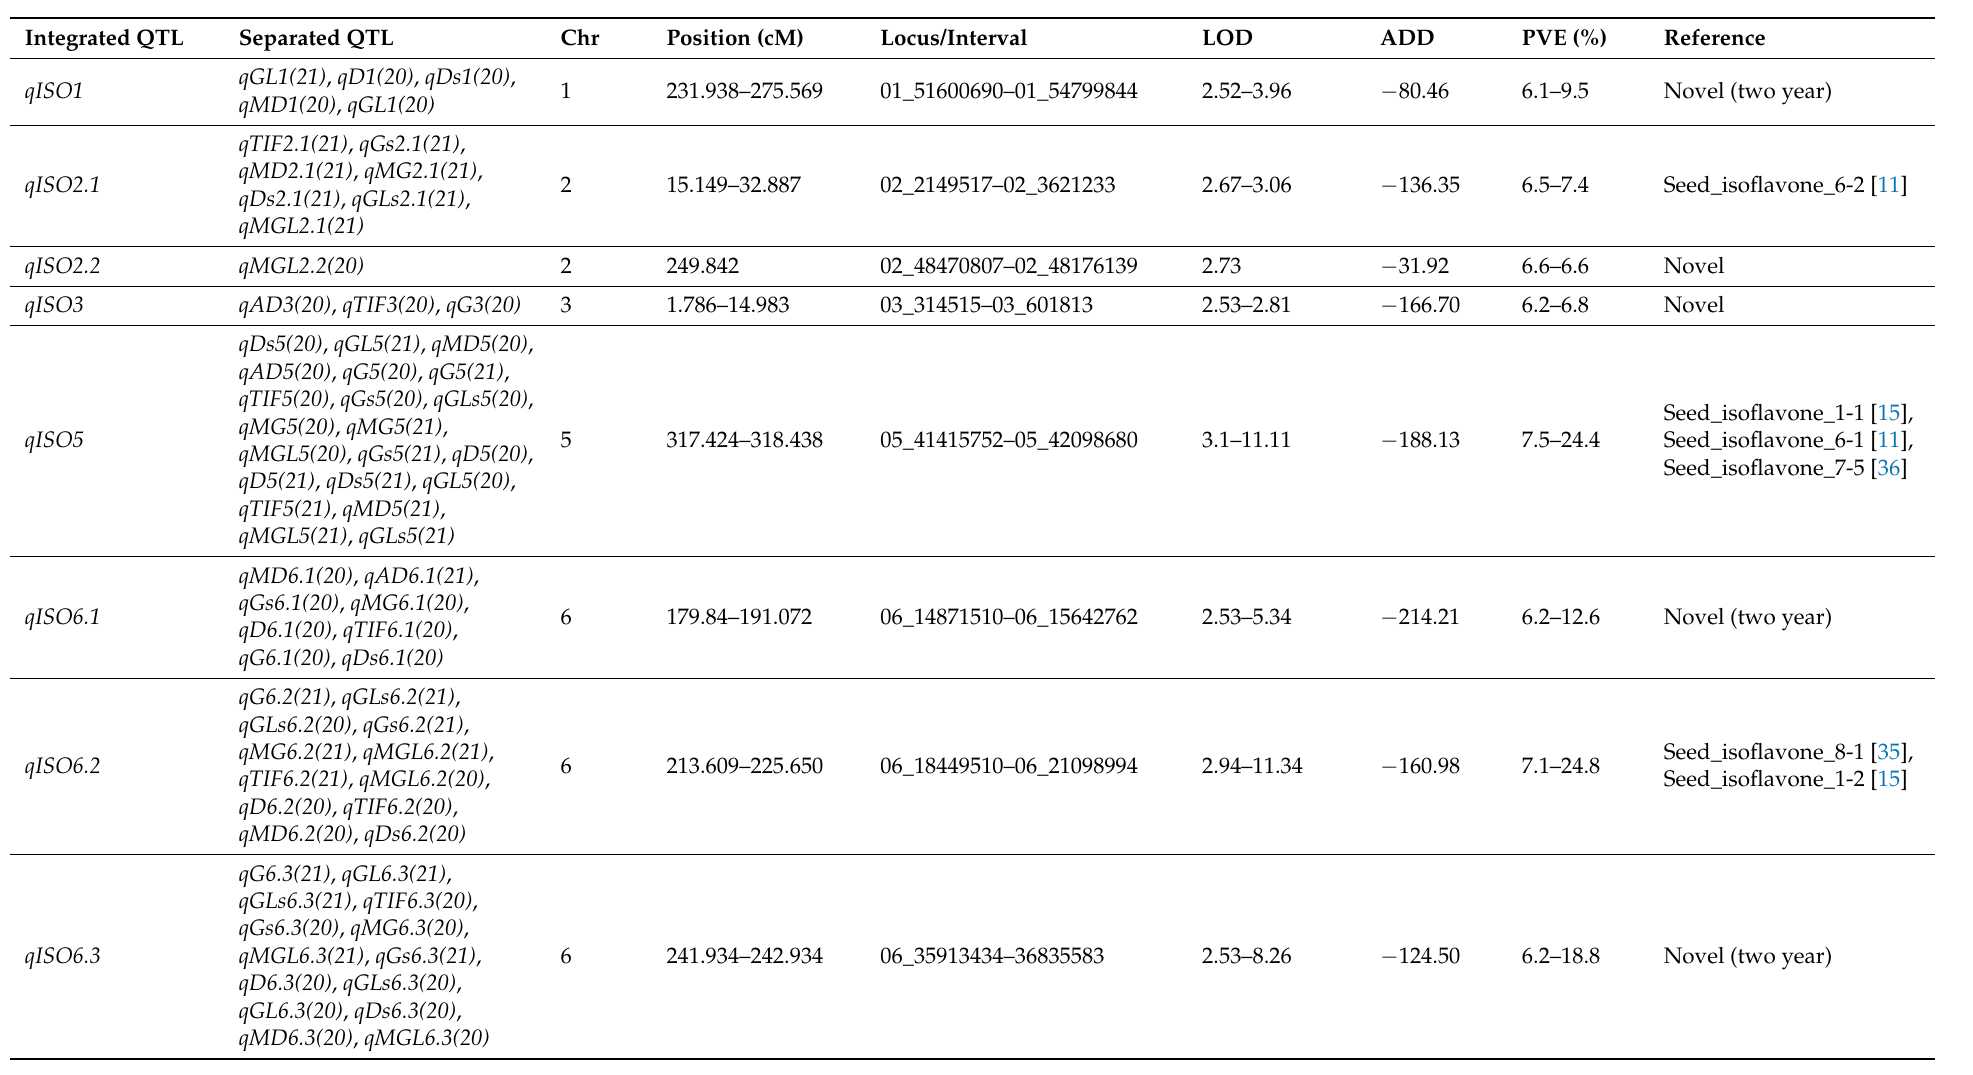
Table 2. Putative QTLs for soybean isoflavone traits detected in a population of contrasting soybean parents and 185 RILs. Integrated